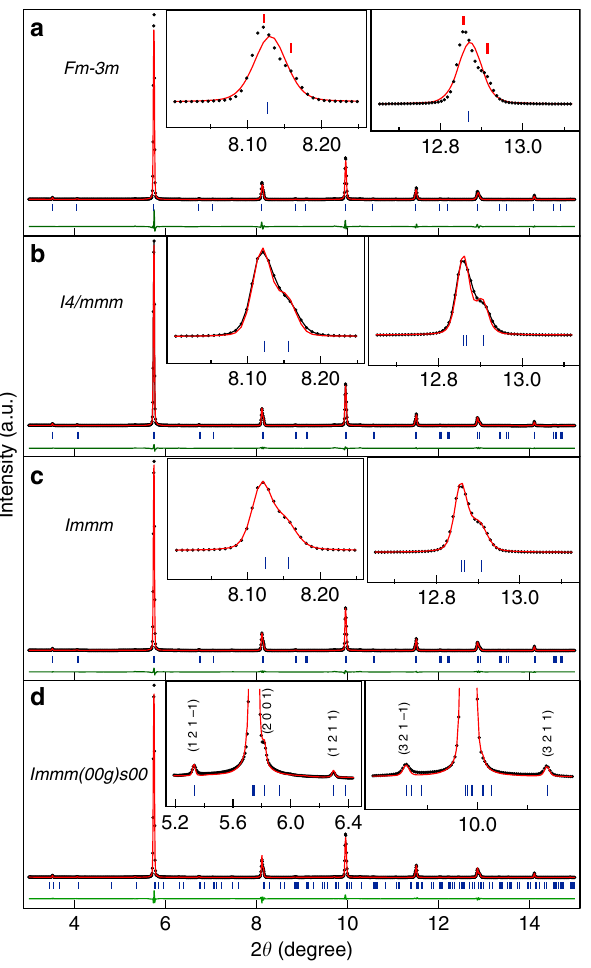
Fig. 4 Rietveld fi ts for the synchrotron X-ray powder diffraction patterns for main peaks at 225 K. Rietveld re fi nements with a cubic austenite cell b Bain-distorted tetragonal unit cell c Orthorhombic unit cell. d Rietveld fi ts with 3 M modulated incommensurate premartensite structure. The experimental data, fi tted curve, and the residue are shown by circles (black), red continuous line, and green continuous line, respectively. The tick marks (blue) represent the Bragg peak positions. The insets in a – c show the fi t for the main re fl ections and in d for satellite re fl ections corresponding to the premartensite (PM)